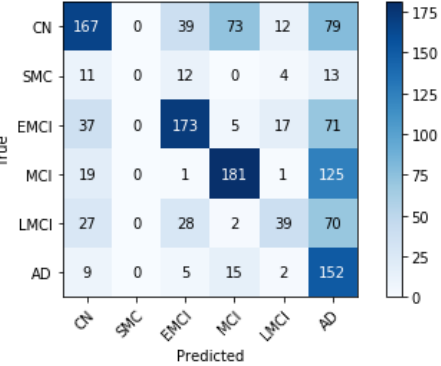
Figure 3. Confusion matrix with the SMC class at 50 epochs.